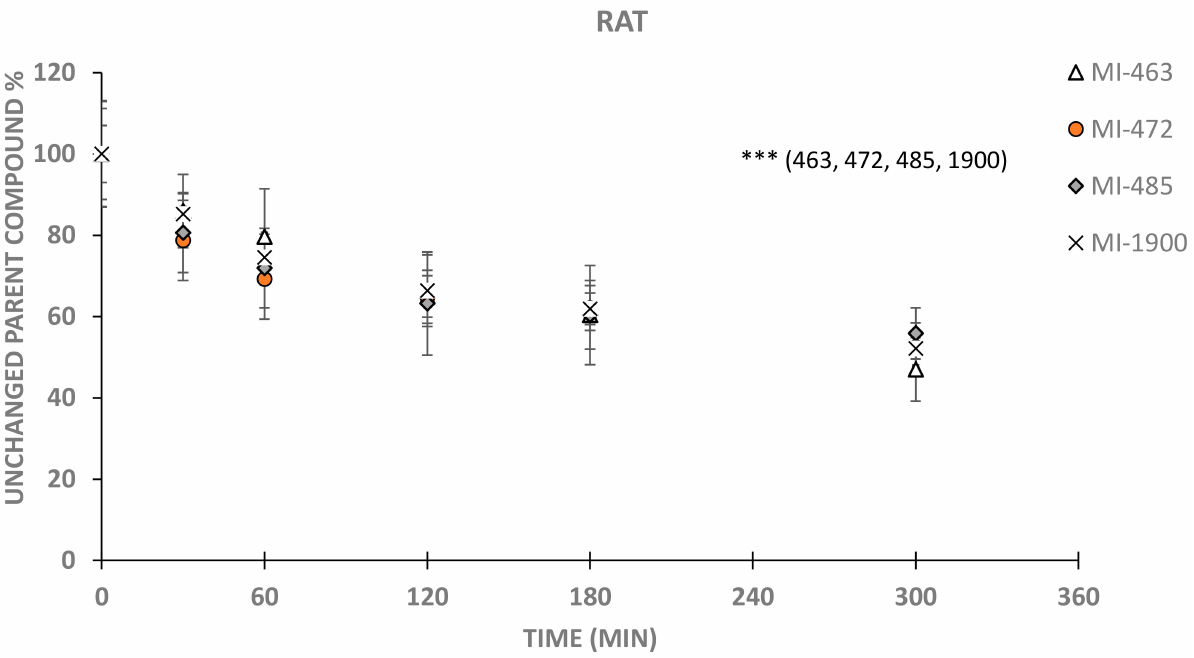
Figure 2. Time course of depletion of inhibitors MI-463, MI-472, MI-485 and MI-1900 in rat primary hepatocytes (5 × 10 5 /mL) using 0, 30, 60, 120, 180 and 300 min sampling times. Relative percentage values of unchanged parent compounds were calculated by dividing the concentrations of the inhibitor measured at a given time point by mean starting MI concentration in the treatment solution (mean ± SD; n = 3–9/group). Asterisks indicate significant differences compared to starting values of the indicated inhibitors in parentheses at 300 min (*** p <